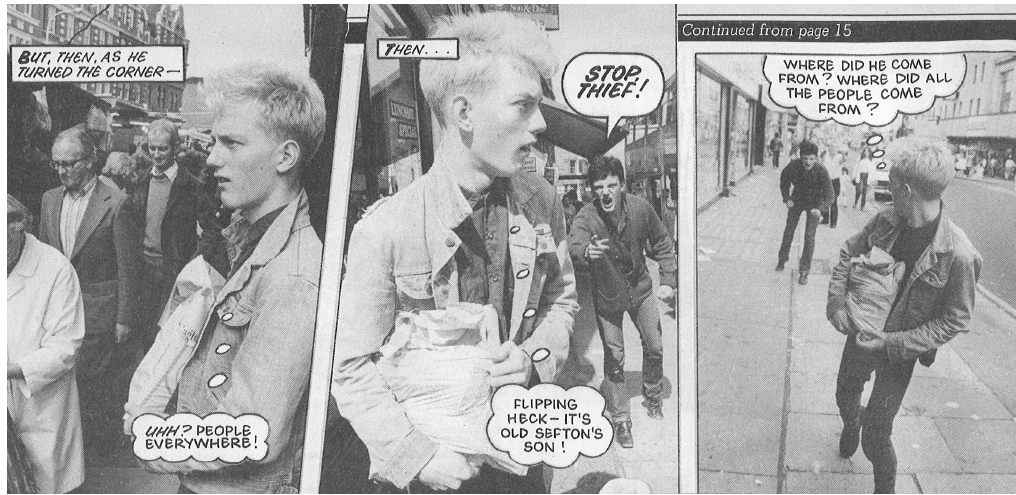
Figure 4. An example of a photo strip (Eagle, 20 November 1982).